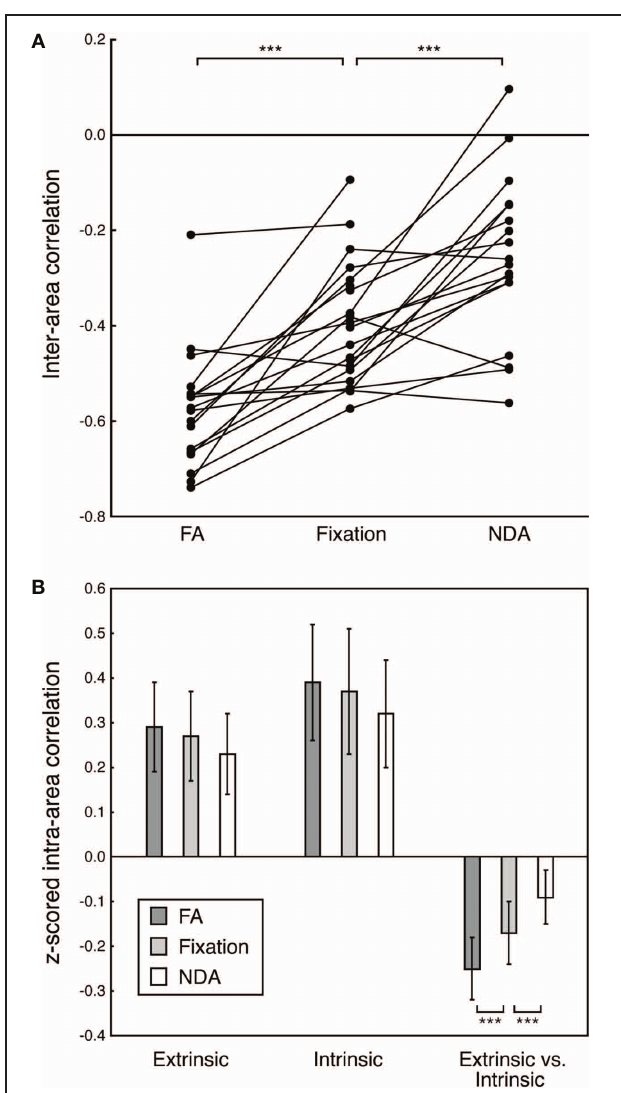
FIGURE 4 | Anti-correlation between extrinsic and intrinsic systems. (A) Correlation between activity in extrinsic and intrinsic systems. FA, focused attention. Fixation, fixation without meditation. NDA, non-dual awareness. Each data point corresponds to fMRI responses from one participant, averaged across all voxels in each of the two systems (extrinsic, intrinsic). Lines connect correlations from the same participant across conditions. Asterisks, statistically significant differences in correlation across participants ( p < 0 . 005, randomization test). Mean correlations across participants: FA, r = − 0 . 58; Fixation, r = − 0 . 41; NDA, r = − 0 . 22. (B) Correlations between activity in extrinsic and intrinsic ROIs. fMRI response time-series were z -scored and averaged across voxels in each ROI. A correlation coefficient was then computed for each pair of ROIs, separately for each participant. Height of each bar, Fisher-transformed correlation coefficients, averaged across pairs of ROIs and averaged across participants. Extrinsic, average across all pairs of extrinsic system ROIs. Intrinsic, all pairs of intrinsic ROIs. Extrinsic vs. Intrinsic, all extrinsic-intrinsic pairs. Error bars, SEM across participants. Asterisks, statistically significant differences in correlation across participants ( p < 0 . 005, randomization test).